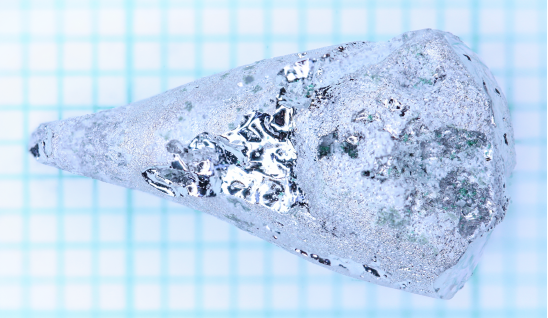
Figure 1. Polycrystalline Co 8 Zn 8 Mn 4 sample mixed under argon of the dimensions 0.8 cm × 1.4 cm and a mass of 2 g. Each grid line corresponds to 1 mm.